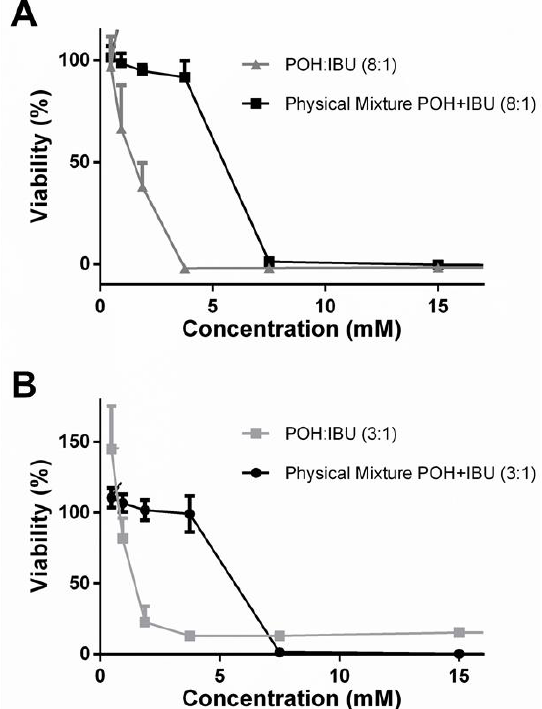
Figure 7. Comparison of the antiproliferative effect of THEDES and a physical mixture of POH and IBU. ( A ) POH:IBU 8:1 and a physical mixture of POH and IBU dissolved in cell culture medium using the same concentration as in the THEDES; ( B ) POH:IBU 3:1 and a physical mixture of POH and IBU dissolved in cell culture medium using the same concentration as in the THEDES. Results were expressed relatively to the control as the mean ± SD of three independent experiments performed in